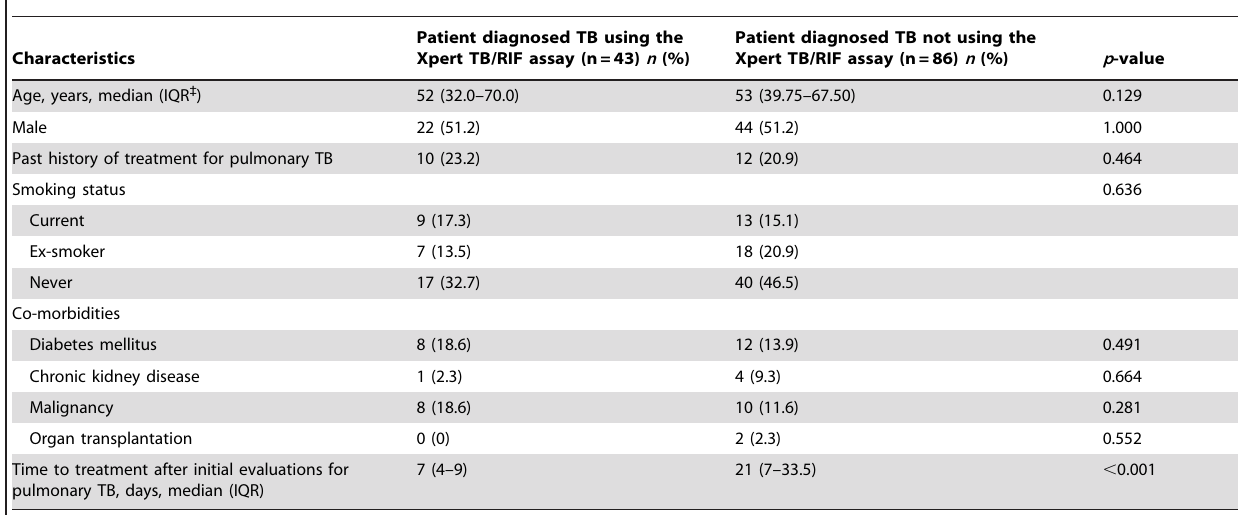
Table 6. Comparison of the clinical characteristics of patients diagnosed with pulmonary TB with or without the Xpert MTB/RIF.